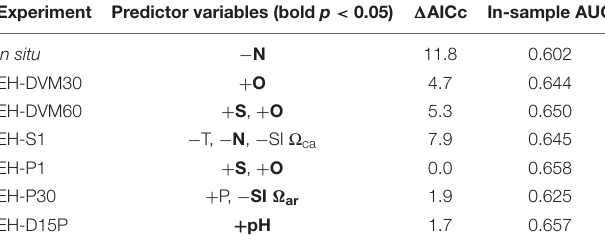
TABLE 4 | Predictor variables [significant predictors in bold ( p < 0.05)] and their direction of correlation to megalopae occurrence for generalized linear models (GLMs) developed using surveys from 2009 to 2016 (see Supplementary Table 5 for additional statistics and Supplementary Tables 6, 7 for results from the sliding window analysis).